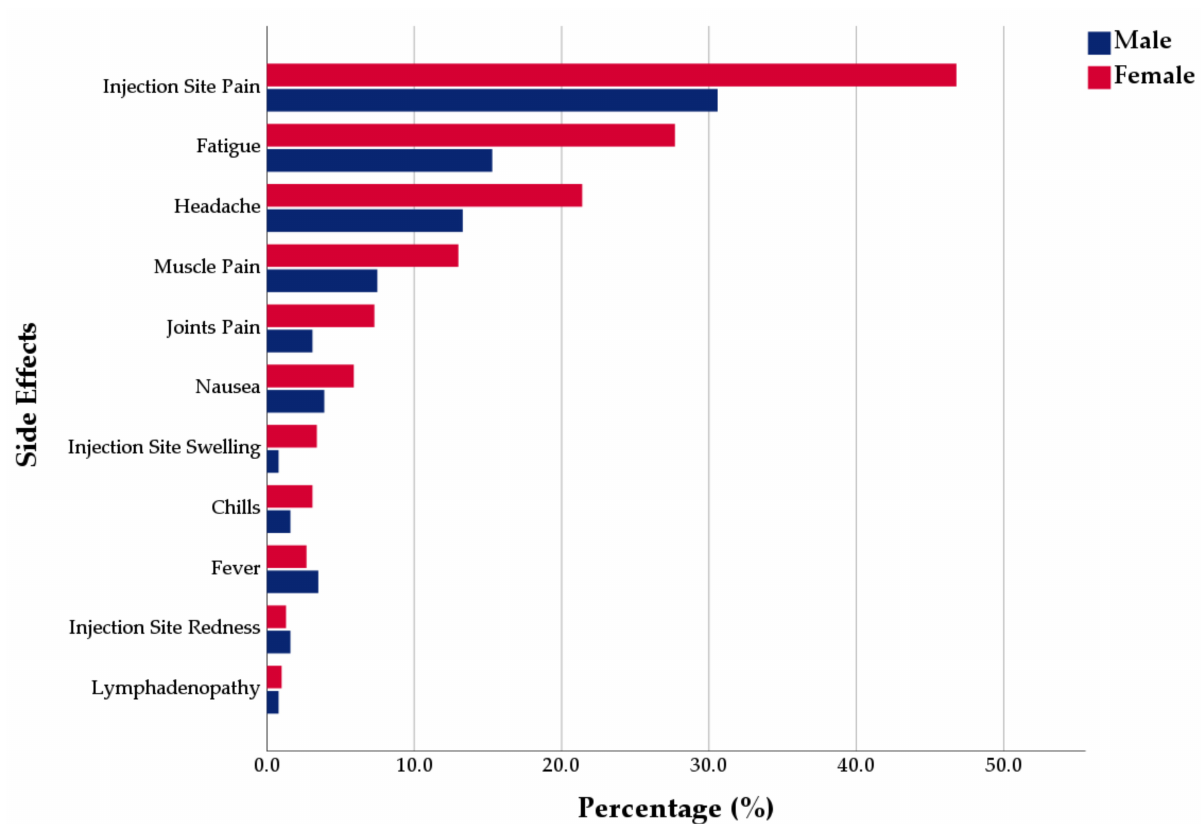
Figure 1. Gender difference of CoronaVac general side effects reported by Turkish healthcare workers, from January– February